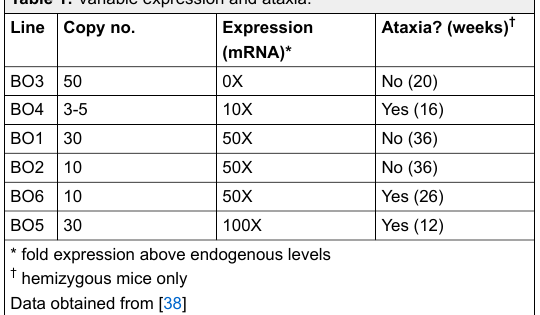
Table 1: Variable expression and ataxia. Line Copy no.